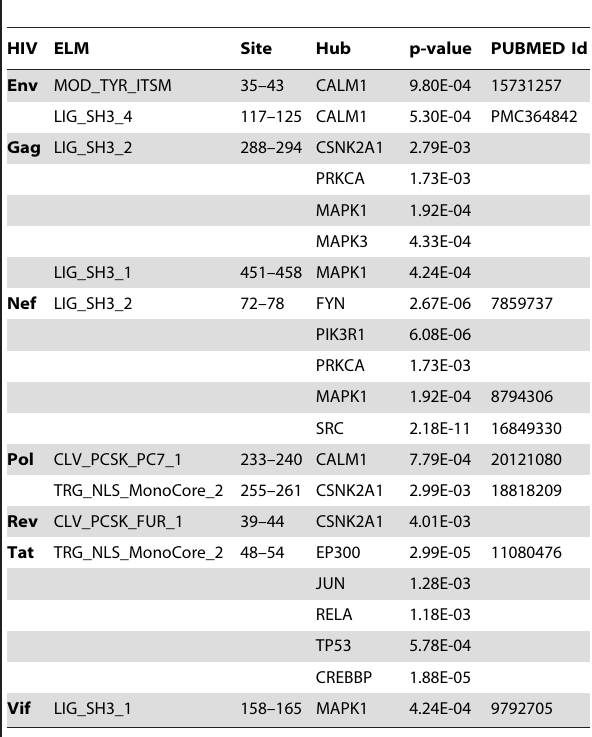
Table 2. Eukaryotic linear motifs (ELMs) present on HIV and enriched among neighbors of hub